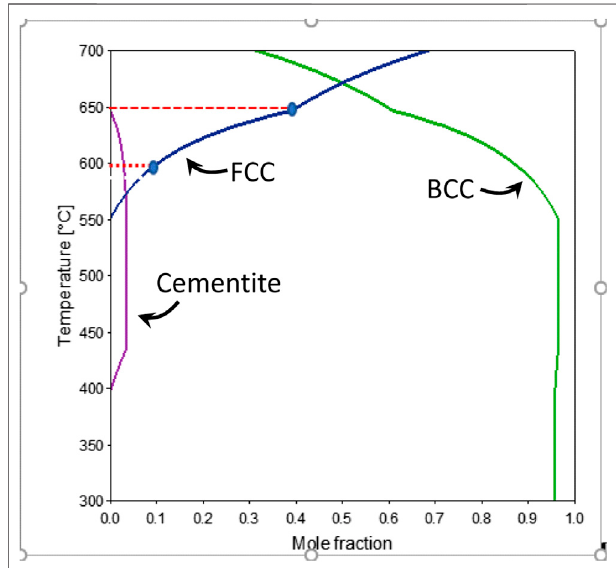
FIGURE 5 | Equilibrium mole fraction of different phases in the material determined by Thermo-calc. BCC stands for ferrite and FCC stands for